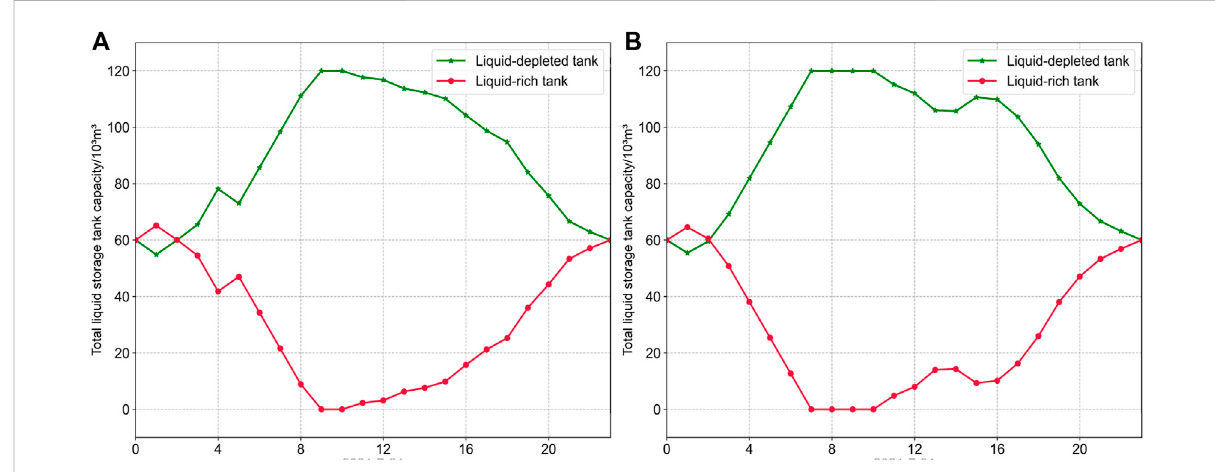
FIGURE 16 Comparison ofreservoirchangesintheday-aheaddispatchofCase1( (A) considering theBelgiangridforecastwindpower, (B) consideringthe GRU forecast wind power).